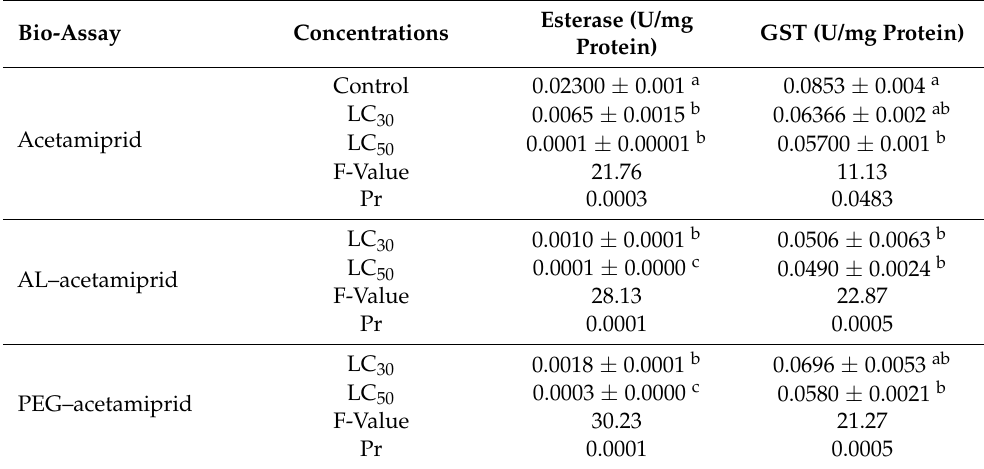
Table 3. Effect of pure and nanoencapsulated acetamiprid on the activity of glutathione S-transferase (GST) and esterase in third-instar larvae of Xanthogaleruca luteola